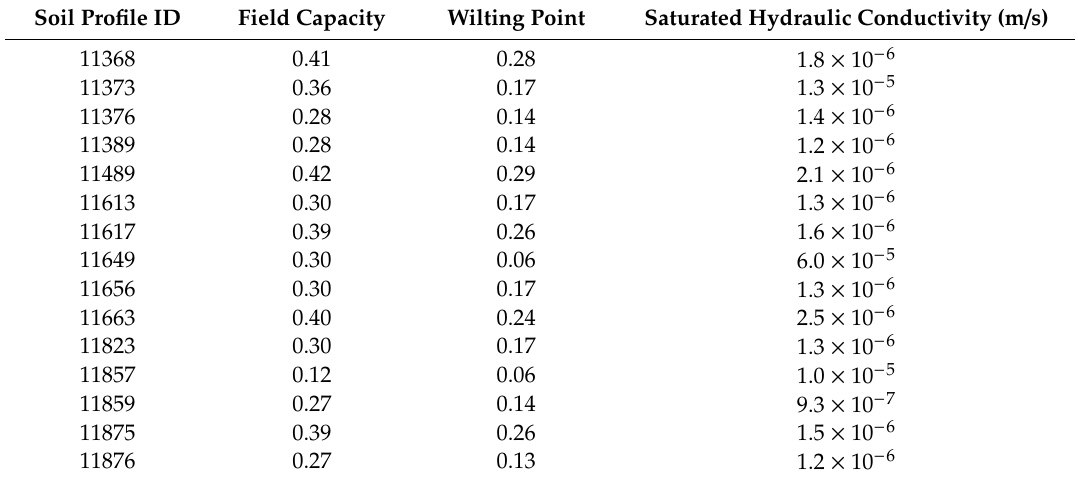
Table A1. The key soil physical parameters of upper soil layer.